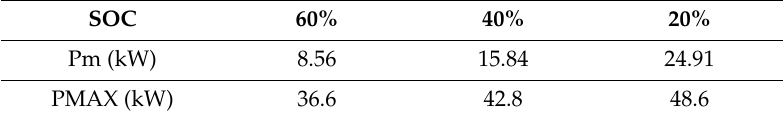
Table 5. Power delivered during fast charges for di ff erent initial values of the